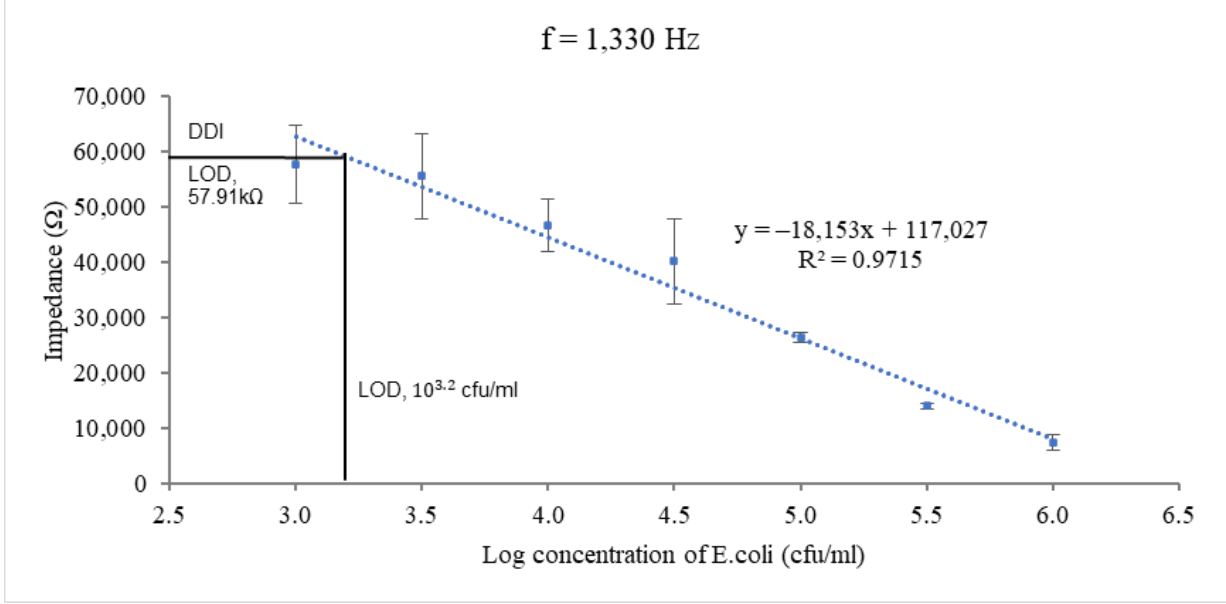
Figure 9. Calibration curves of the impedance magnitude of E. coli samples at different concentrations tested at the optimum frequency of 1.3 kHz. The limit of detection was determined by means of NC − 3 x standard deviation of NC. R 2 is the coefficient of determination between the sensor’s impedance response and the logarithmic concentration of E. coli .